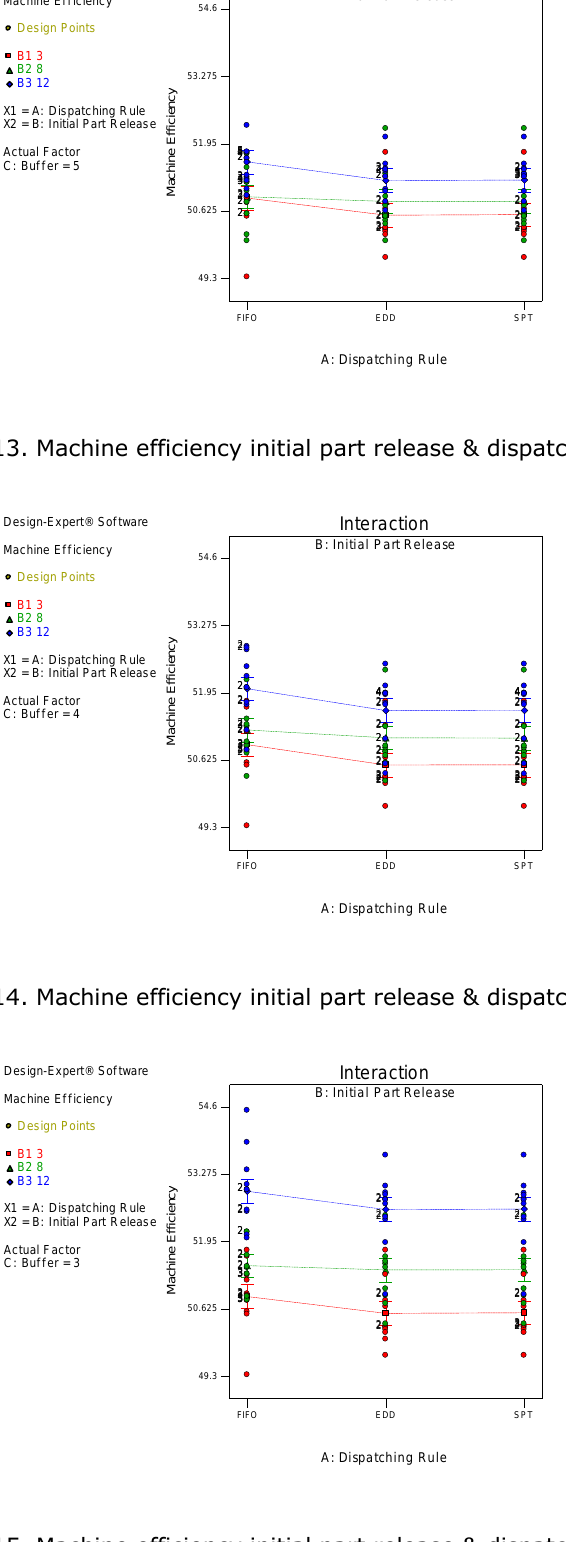
Figure 15. Machine efficiency initial part release & dispatching rule Figure 13 to 15 show the interaction between the initial part release factor and the selected dispatching rule. It can be seen the selected dispatching rule does